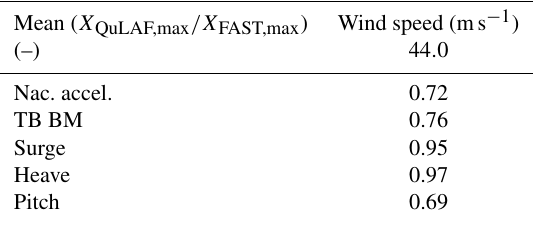
Table 9. Ratio of max. response (QuLAF / FAST) averaged per wind speed for DLC